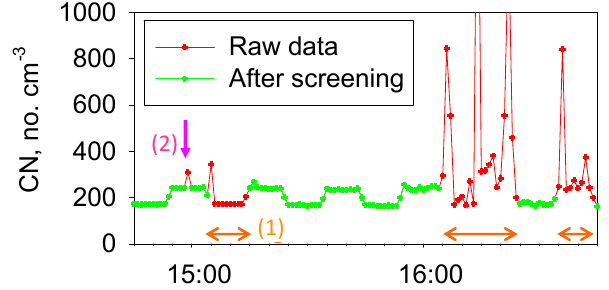
Figure 3. Results for CN concentrations measured before and after screening. Data for periods of orange arrows indicate removal by screening (1). Data indicated by pink arrows are data removed by screening